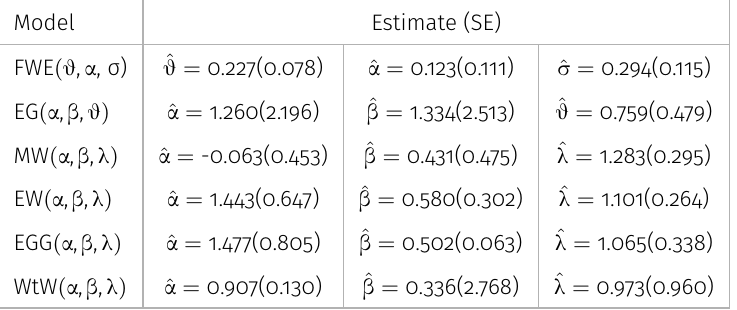
Table III. The MLEs and SEs of the parameters of the distributions for failure times data. Model Estimate (SE)